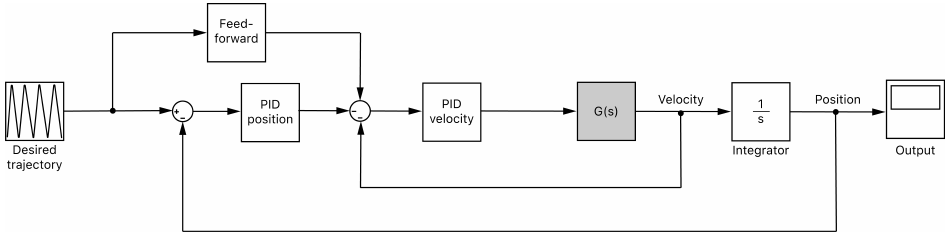
Figure 8. Control scheme for the motors. Two feedback controllers are used both for velocity and position and a feed-forward scheme is implemented to correct undesirable delays in the response.